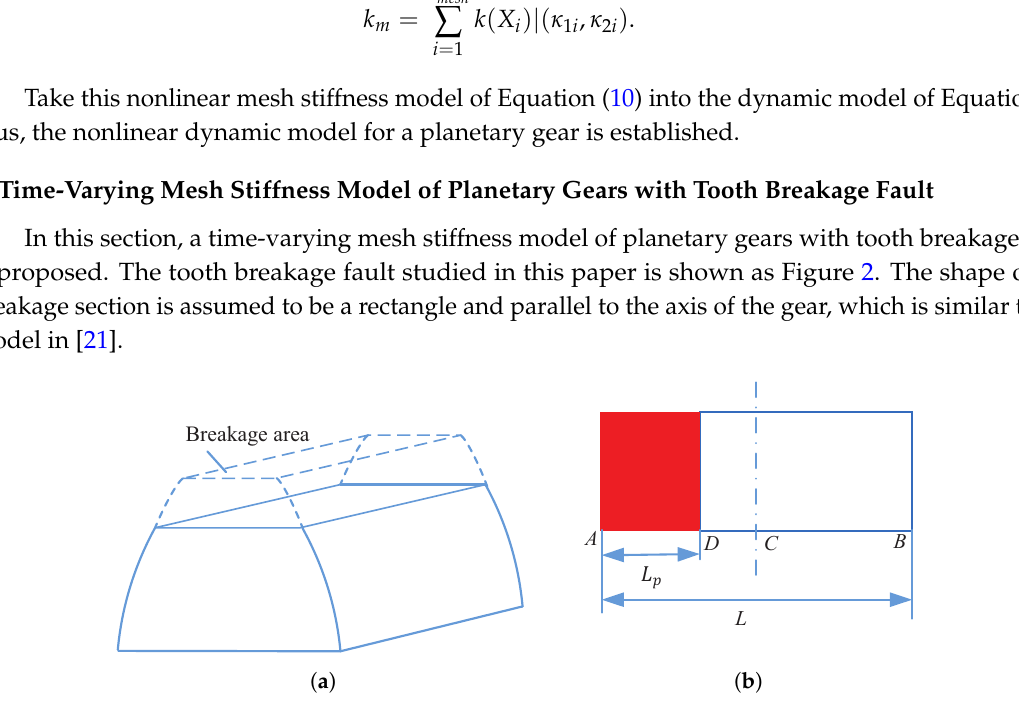
Figure 2. Sketch map for the tooth breakage fault, ( a ) variation of the tooth profile; ( b ) variation of the contact